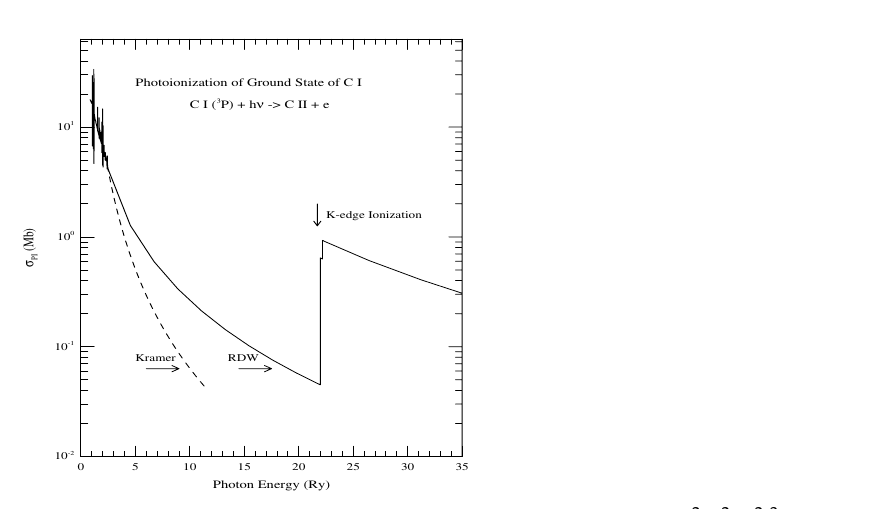
Figure 3. Photoionization cross section σ PI of the ground state of CI, 1 s 2 2 s 2 2 p 2 3 P , computed using the relativistic distorted wave (RDW) code by H.L. Zhang (discussed in [5]) compared with the Kramer’s hydrogenic formula Equation (17). The large jump is due to photoionization of the inner 1 s − shell or the K − edge. The resonance structures at very low energies are obtained from the coupled channel RM calculations in the Opacity